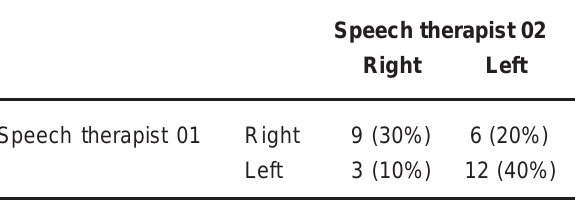
TABLE 3- Agreement between palpation of speech therapists 01 and